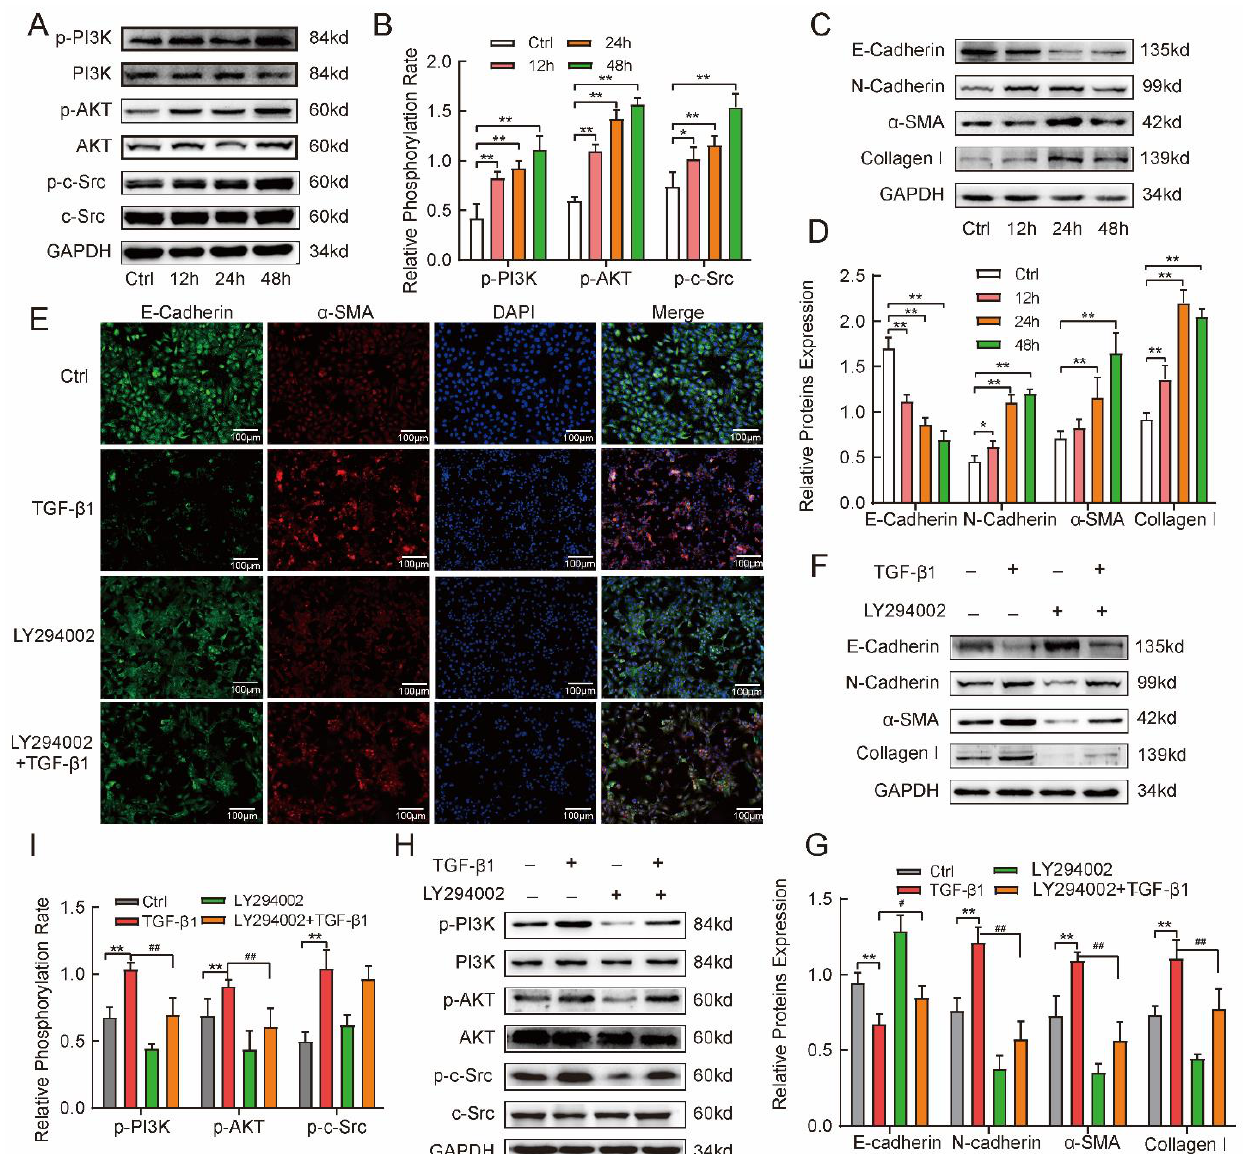
Figure 4. TGF- β 1 induced mesenchymal phenotype via activation of the PI3K/AKT pathway in MLE-12 cell. ( A – D ) MLE-12 cells were treated with 5 µg/L TGF- β1 for 12 h, 24 h, and 48 h and the phosphorylation of PI3K/AKT and cell phenotype-related markers (E-cadherin, N-cadherin, α -SMA, and collagen I) were measured by Western blotting. ( E ) E-cadherin (green-fluorescent) and α -SMA (red-fluorescent) at 48 h after treatment in the presence and absence of 5 µg/L TGF- β1 with/without the PI3K inhibitor LY294002 (5 µM) were observed with immunofluorescent staining (The cell nucleus were labeled blue by DAPI). ( F – I ) The phosphorylation of PI3K, AKT and pheno- type-related markers in MLE-12 cells at 48 h after treatment in the absence or presence of 5 µg/L TGF- β1 with/without the PI3K inhibito r LY294002 (5 µM) were determined by Western blotting. LY294002 was used to determine whether mesenchymal phenotype in the alveolar epithelia was regulated by the PI3K/AKT pathway. One-way analysis of variance. Values are the mean ± SD from triplicate experiments. * p < 0.05, ** p < 0.01 vs. control group; # p < 0.05, ## p < 0 .01 vs. TGF β1 group. 2.5. Phosphorylated c-Src Activated the PI3K/AKT Pathway Involved in TGFβ1 -Induced Mesenchymal Phenotype in MLE-12 Cells As previously described, phosphorylation and activation of the PI3K/AKT pathway is associated with fibrosis in silicosis. Protein tyrosine kinases catalyze phosphorylation reactions. We confirmed that c-Src, a critical non-receptive tyrosine kinase, was activated by phosphorylation in in vitro and in vivo silicosis models. Therefore, we sought to